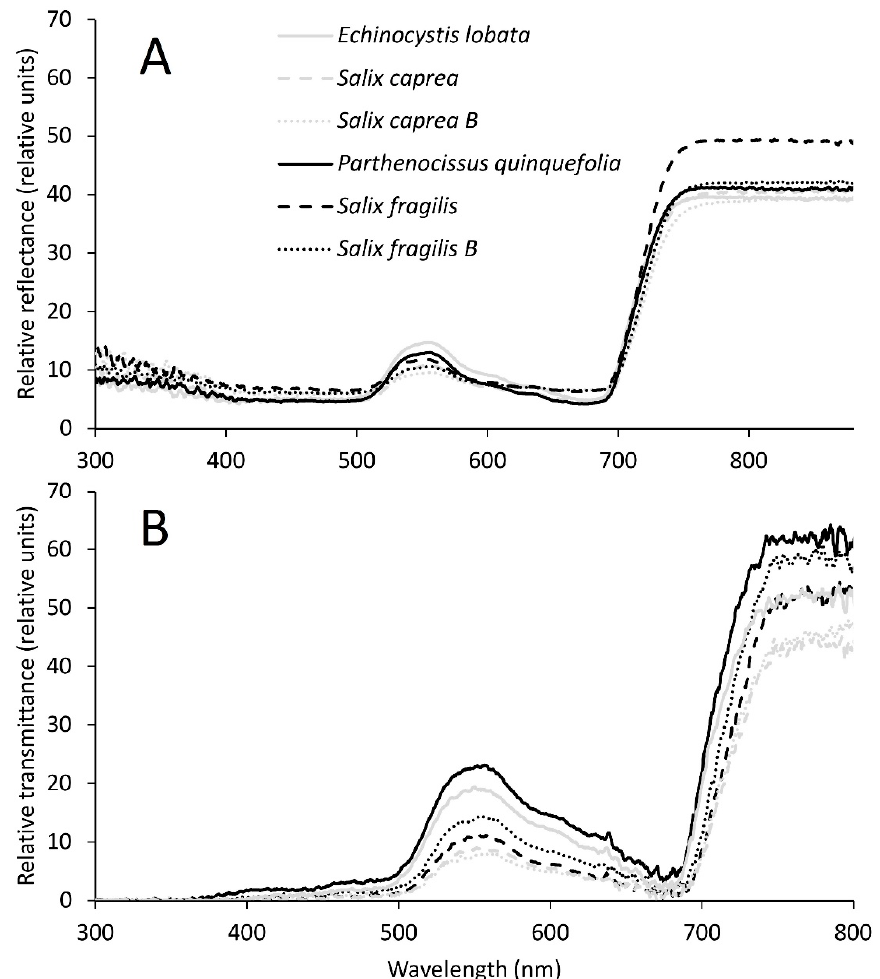
Figure 2. Relative reflectance ( A ) and transmittance ( B ) spectra of the vines and their host willows. Data are for the stands of S. fragilis without ( Salix fragilis ) and overgrown by P. quinquefolia ( Salix fragilis B ), and for those of S. caprea without ( Salix caprea ) and overgrown by E. lobata ( Salix caprea B ).